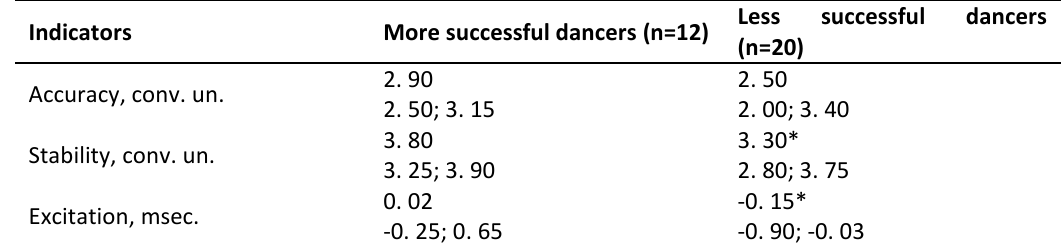
2. 90 2. 50; 3. 15 3. 80 3. 25; 3. 90 0. 02 -0. 25; 0. 65